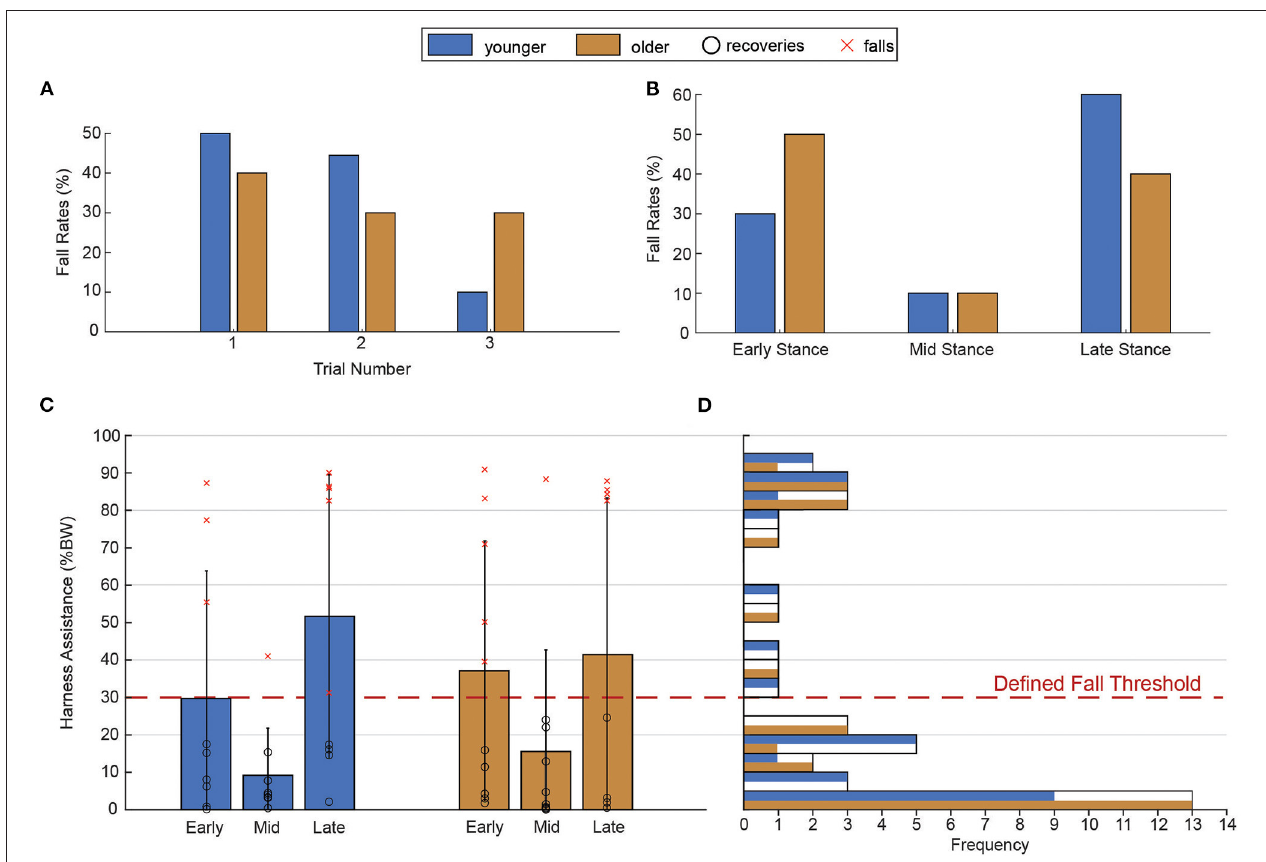
FIGURE 2 | Fall rates disaggregated by age group, trial, stance phase of slip onset, and level of harness assistance. (A) Fall Rate (#Falls/Overall Trials) is presented for each trial and between age group. (B) Fall Rate presented for each slip onset phase and between age groups. (C) Here we demonstrate the change in harness assistance, presented in the x-axis, between younger and older adults across the three different slip onset phases: Early Stance, Mid Stance, and Late Stance. The x -axis shows the peak harness-assistance forces, measured based on the amount of forces applied to the harness in the participant’s body weight percentage, between slip onset phases (early, mid, and late stance), and groups (younger and older). Error bars represent standard deviation. Dark circles (cid:13) represents the recovery trials and red crosses × represent the fall trials. (D) Overlapped histogram demonstrating the number of trials for each group within blocks of 5% of harness assistance. Each block demonstrates counts for both younger and older participants color coded. The red dashed line represents the fall threshold.